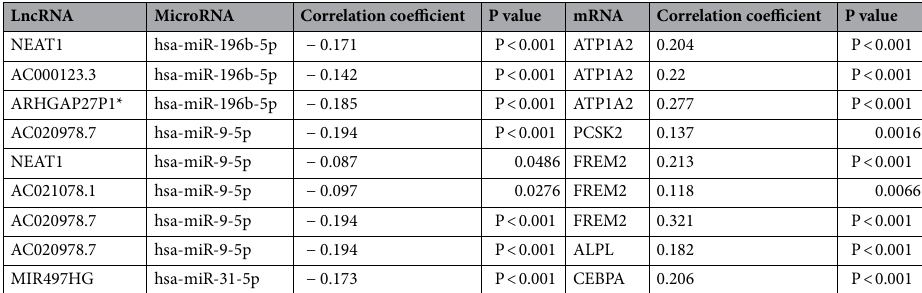
Table 2. The correlation coefficient of lncRNA-microRNA and lncRNA-mRNA in TCGA-LUAD. ARHGAP27P1*,